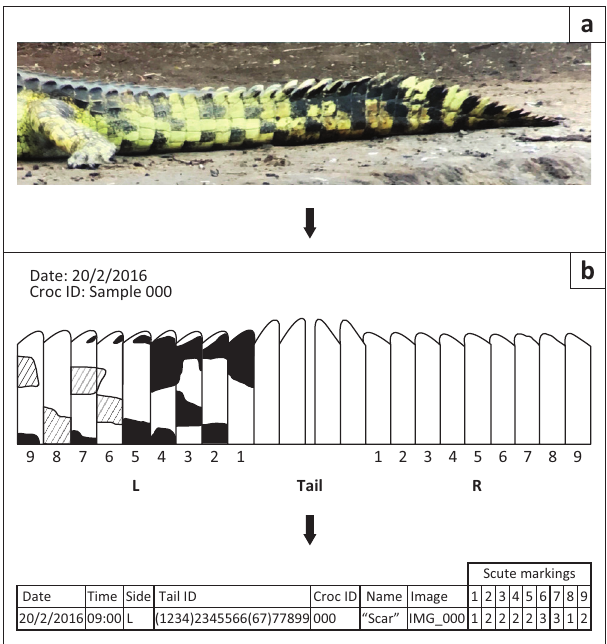
FIGURE 1: Conceptual diagram demonstrating the scute encoding procedure followed, based on photographs of crocodile tail